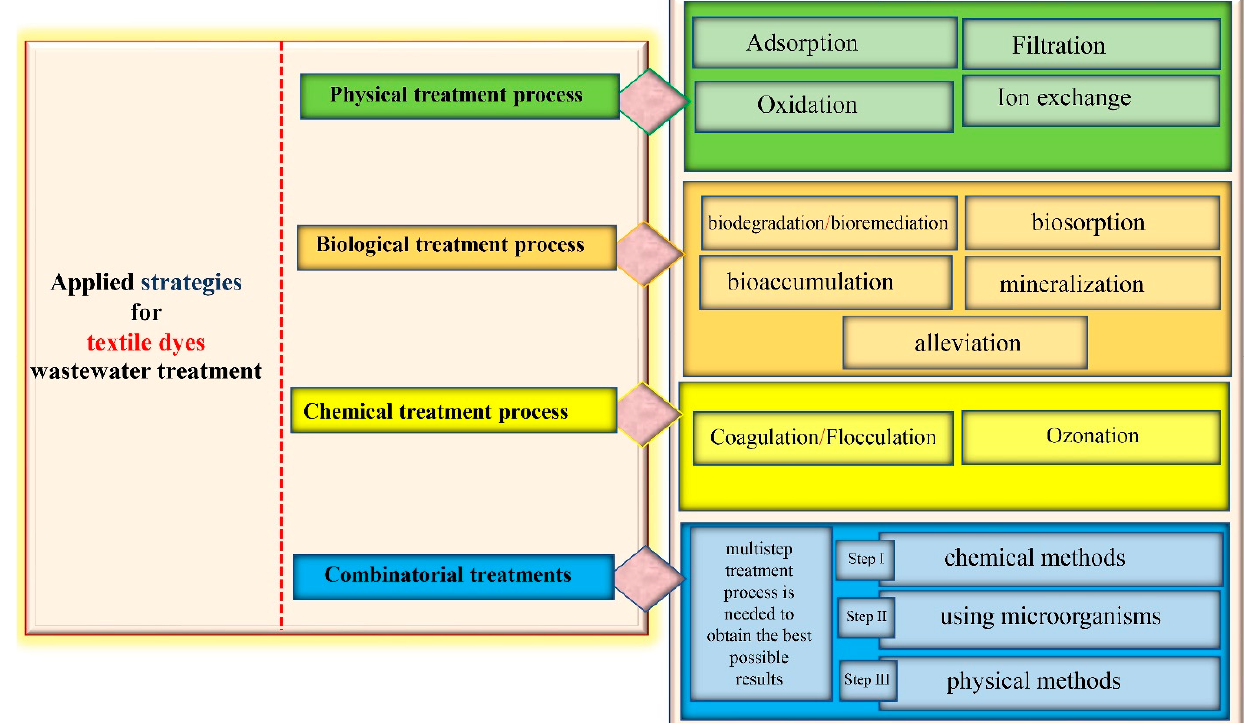
Figure 3. Treatment strategies of textile dyes discharges.